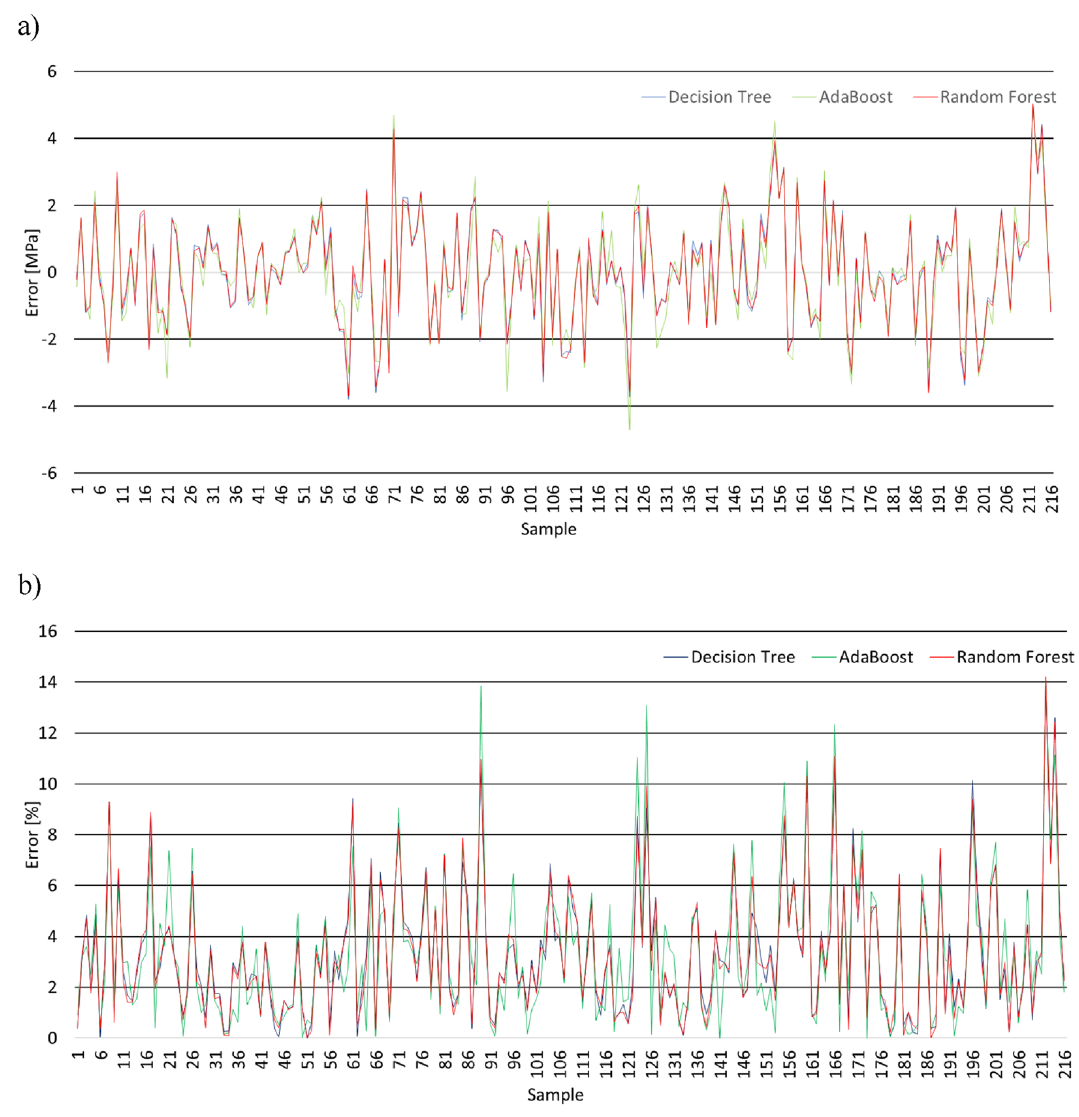
Figure 8. Prediction error distribution: ( a ) values and ( b ) percentage.